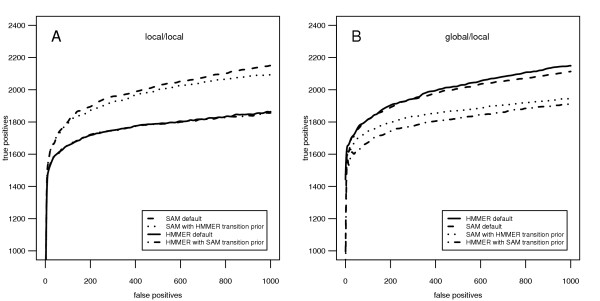
Analysis of transition prior probabilities. (A) Local/local mode. (B) Global/local mode. SAM and HMMER models were built using their own default transition prior, and with default transition prior from the other program. The transition priors seem to be specific to their programs as they degrade the performance of the other program.